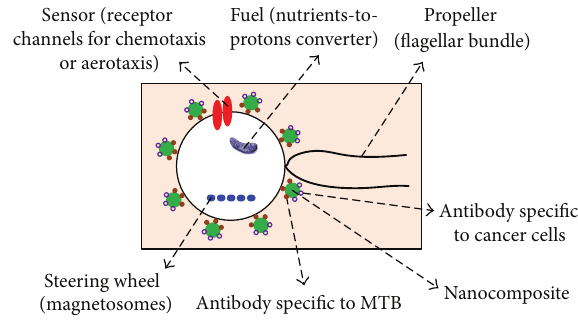
Figure 1: Key functional elements of